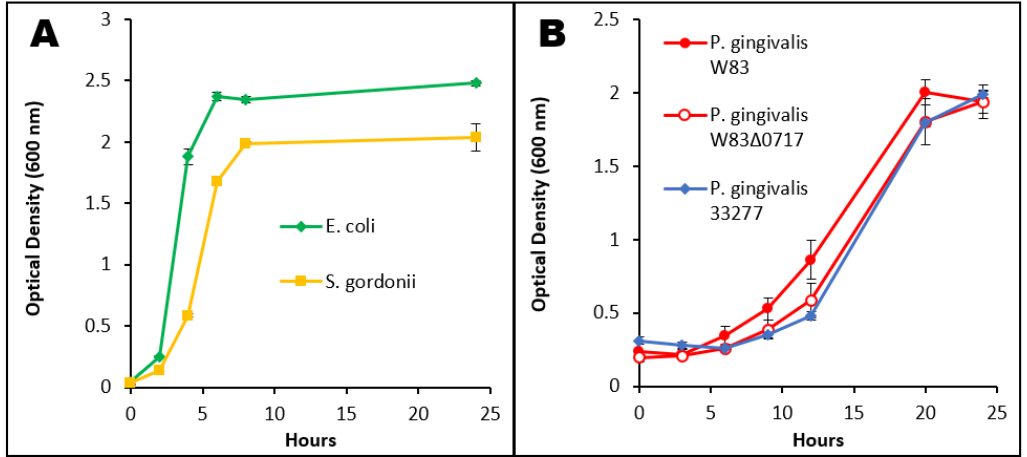
Figure 2. Bacterial growth curves in TSBY, measured by optical density (OD 600 nm ) over the course of 24 h. Commensal species E. coli and S. gordonii ( A ) were grown aerobically, while P. gingivalis strains W83, W83 ∆ 0717, and 33277 ( B ) were grown anaerobically. For each strain, n =